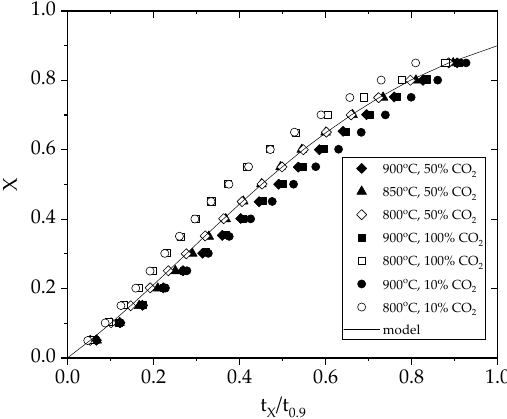
Figure 6. Determination of the structural parameter.